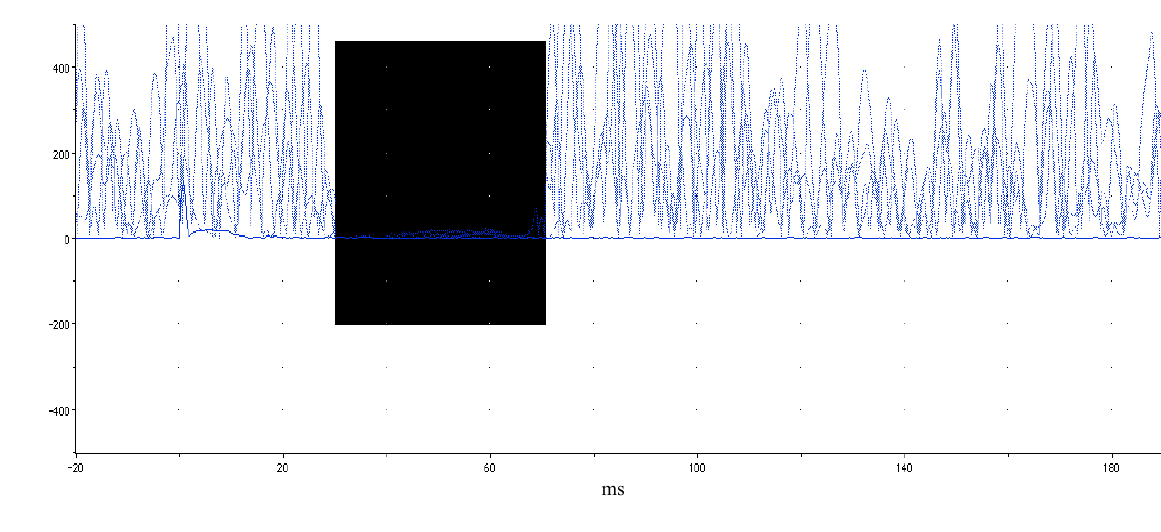
Figure 1. Illustration of ipsilateral silent period. Rectified EMG across multiple trials within a single participant while holding isometric force at 35%–50% MVC. Highlighted (dark) area delineates EMG depression. Motor evoked potential and subsequent silent period occurs at ~38 ms. iSP duration for this participant was 45 ms.